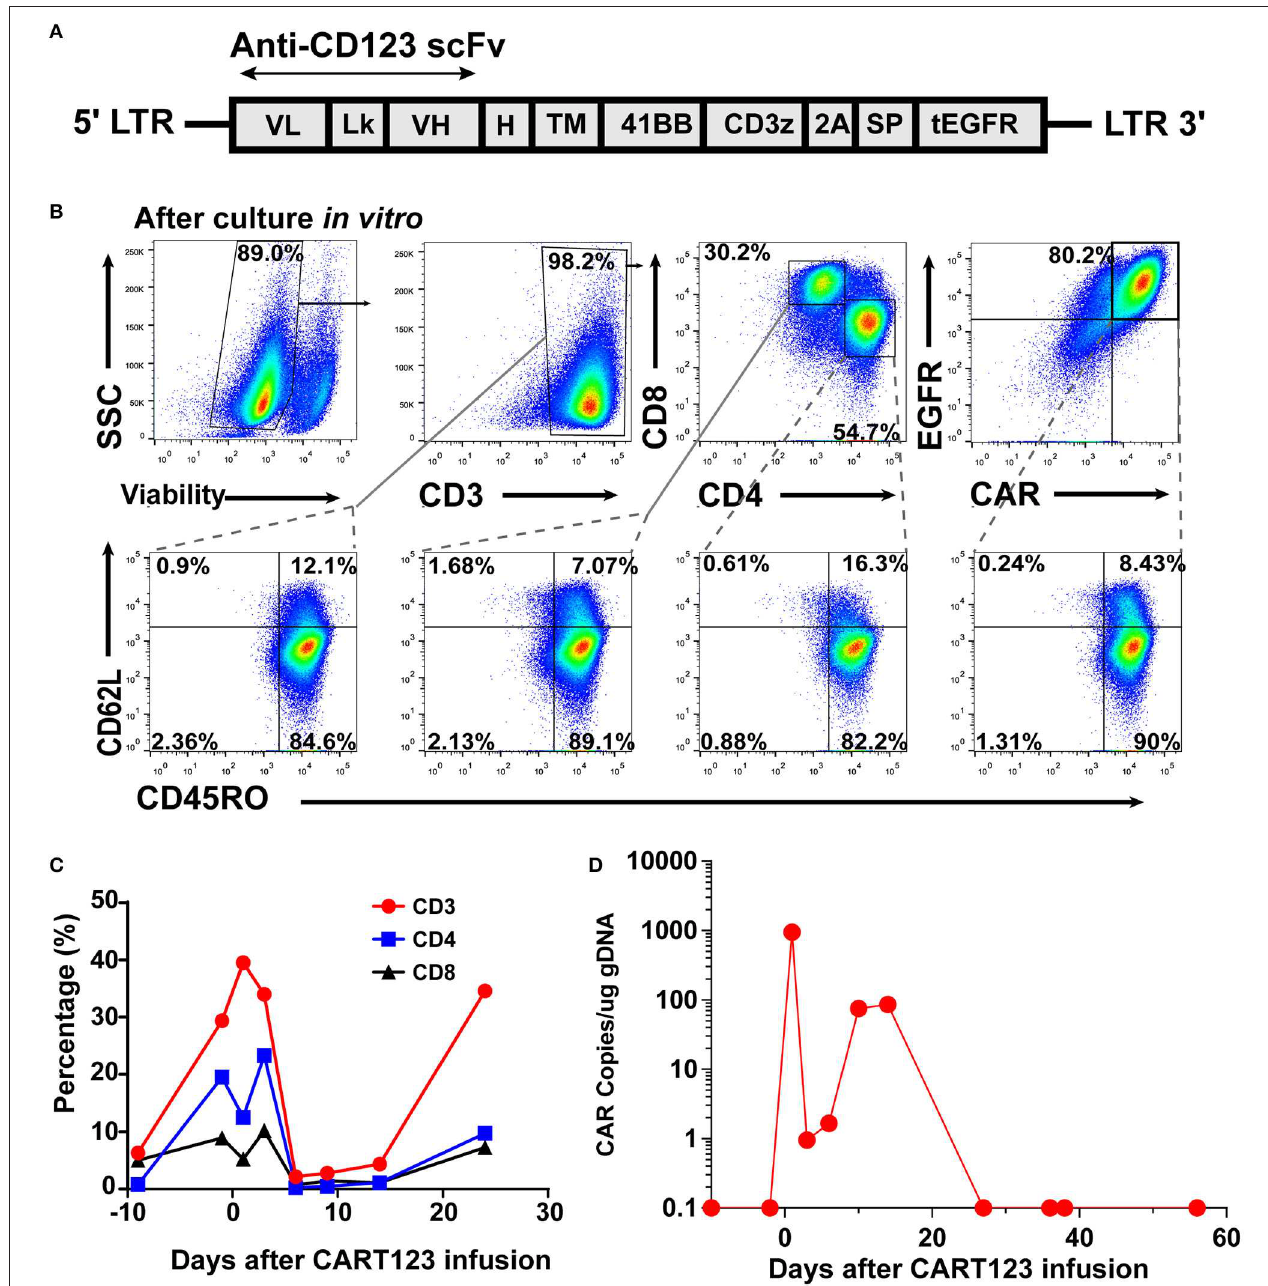
FIGURE 3 | CAR design and expression; the expansion of CART123. (A) The structure of retroviral vectors encoding anti-CD123 CARs (32). The 41BB CAR consisted of anti-CD123 scFv FMC32716, a CD8a hinge region, CD8 transmembrane and cytoplasmic regions, and a CD3 ζ cytoplasmic region. tEGFR was connected with the anti-CD123 CAR via the P2A peptide in this investigation. (B) CAR expression and CD3, CD4, CD8, CD45RO, and CD62L on T cells was detected by flow cytometry. CAR expression on T cells was detected by anti-EGFR antibodies. (C) Changes in the proportion of T lymphocytes in PB after CART123 infusion. (D) Changes in CAR copies in PB after CART123 infusion by qPCR. CAR, chimeric antigen receptor; CART123, CD123-targeted CAR T cell; PB, peripheral blood; qPCR, quantitative polymerase chain reaction; EGFR, human Epidermal Growth Factor Receptor.